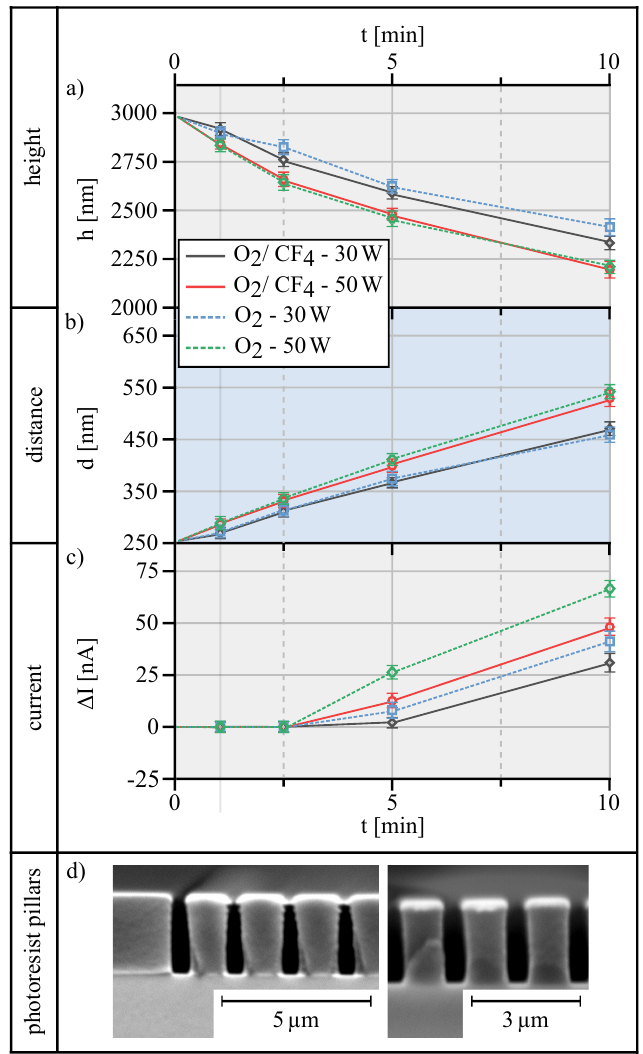
Figure 6. ( a – c ) effect of different etching parameters: process gas O 2 shown as dotted lines, mixed process gas 25% O 2 / 75% CF 4 in solid lines. 30W power corresponds to the black line (mixed gas) and the blue dotted line (pure O 2 ). 50W corresponds to the red solid line (mixed gas) and the green dotted line (pure O 2 ), repectively. In ( a ) the pillar height versus etching time is depicted, whereas ( b ) shows the correlation between etching time and resulting distance in between the pillar structure. The effect of etching on the electrochemical properties of the ITO layer is shown in ( c ) (for details see Section 4.2). Bottom: ( d ) REM image of the untreated pillar structure (left) and the final RIE treated structure